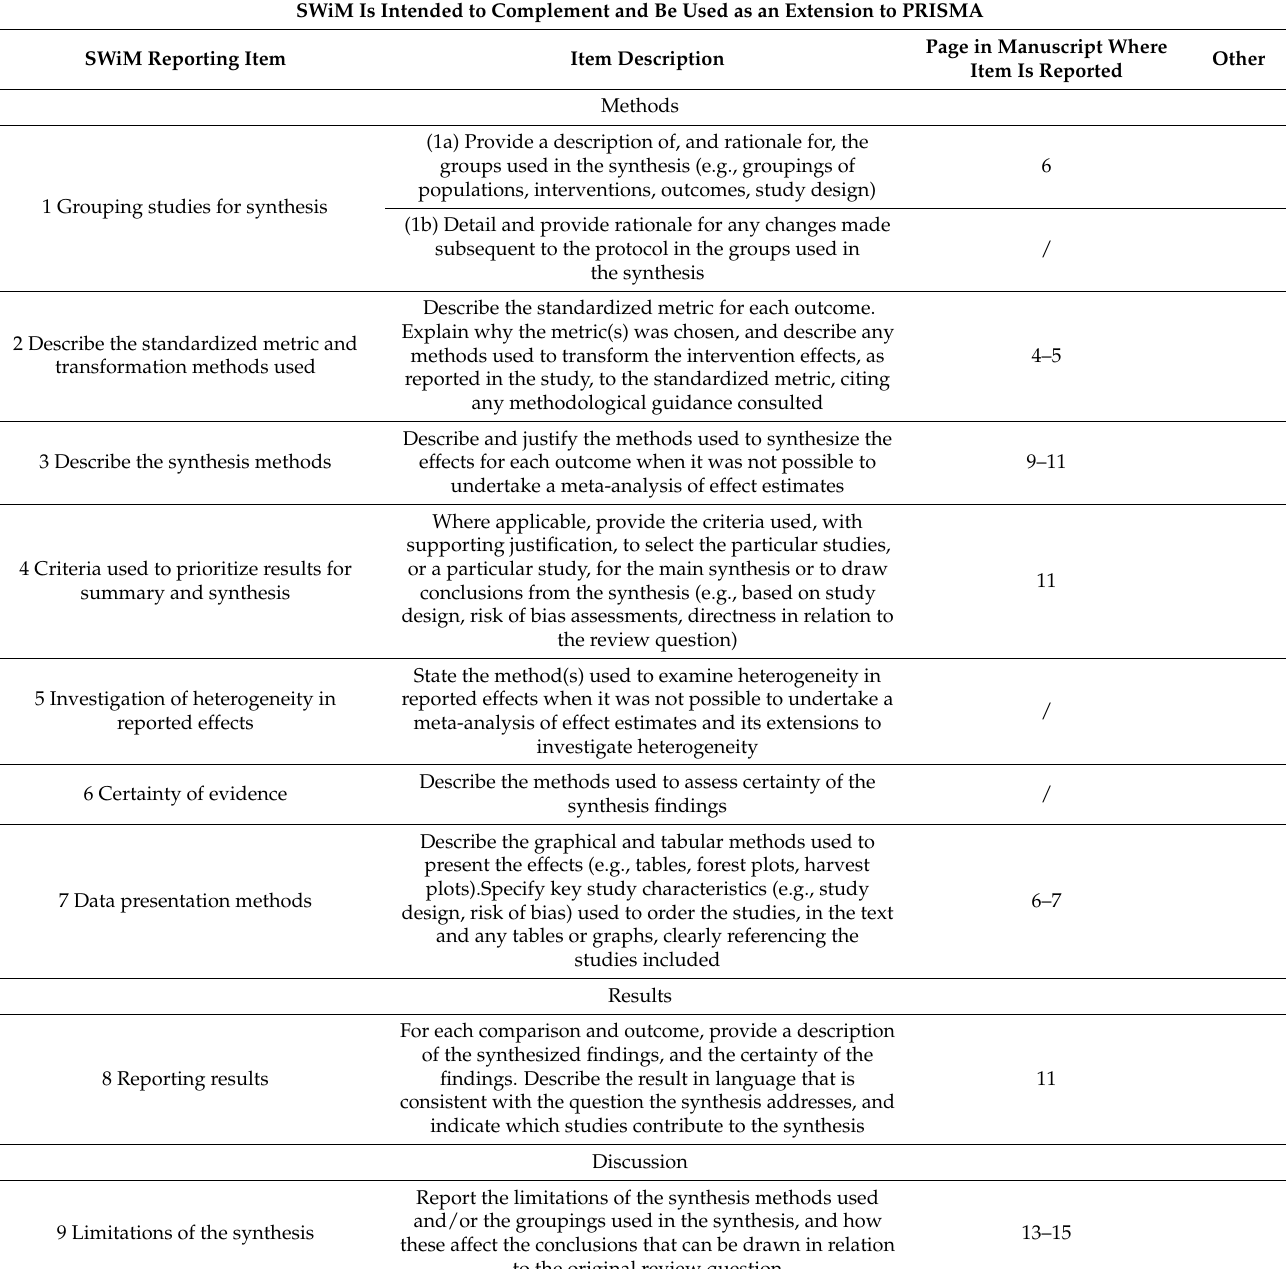
Table A1. Synthesis without meta-analysis (SWiM) reporting